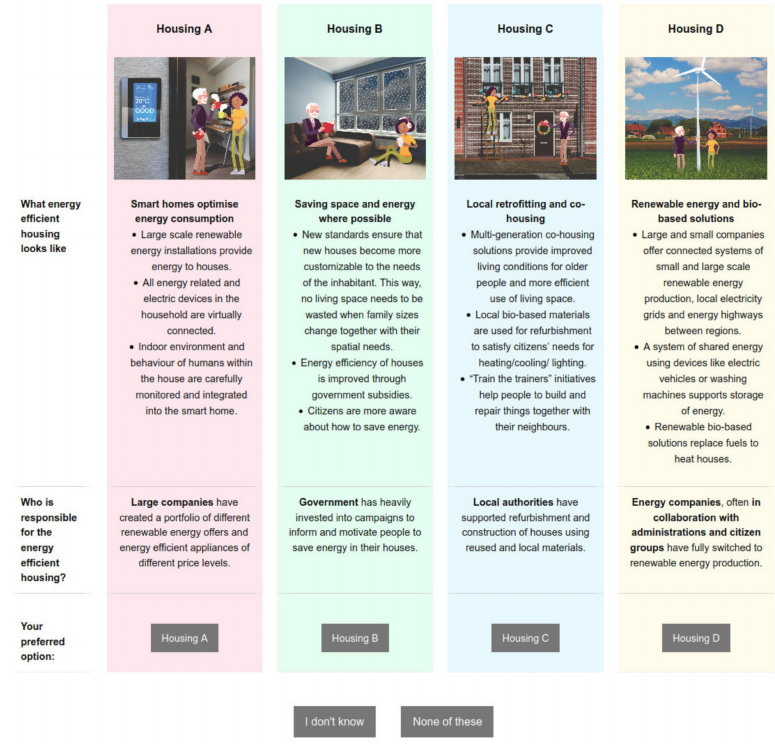
Figure A1. Example of a choice card—INHERIT scenarios, Energy e ffi cient housing domain (Housing A corresponds to the “My life between realities” scenario, Housing B to the “Less is more to me” scenario, Housing C to the “One for all, all for one” scenario, and Housing D to the “Our circular community”